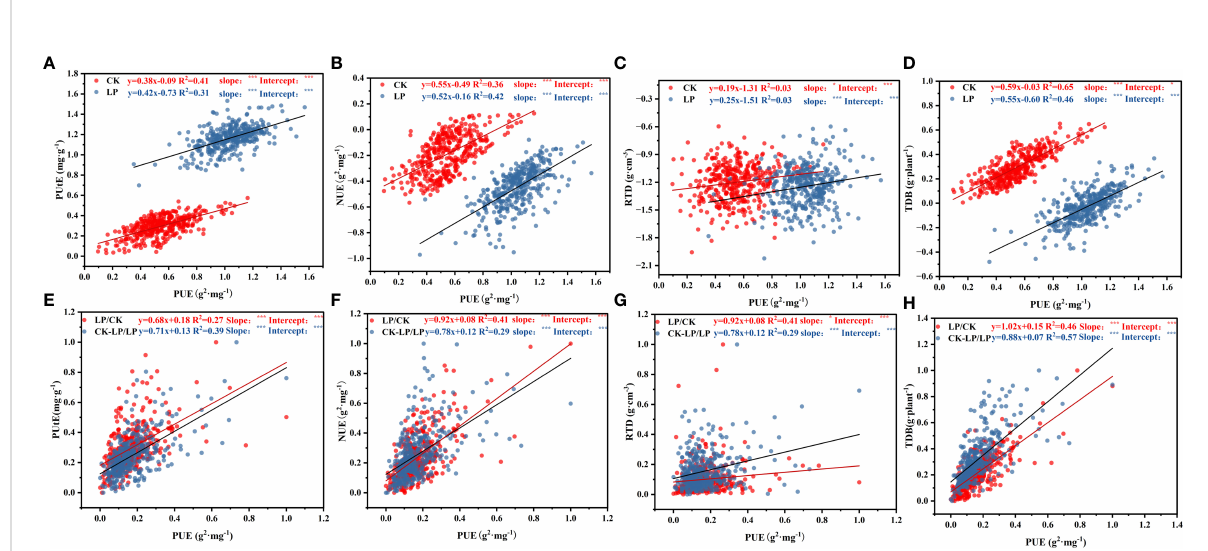
FIGURE 8 Standardized central axis linear relationships in morphological traits between PUE at both P supply and LP/CK, (CK-LP)/LP (Phosphorus stress index). Points are the mean values of four replicates per genotype. The data in fi gures (A – D) were log 10 transformed before analysis, and the data in fi gures (E – H) were normalized before analysis. ∗∗∗ P < 0.001. Trait notations: root tissue density (RTD), total dry biomass (TDB), nitrogen use ef fi ciency (NUE), phosphorus use ef fi ciency (PUE), phosphorus uptake ef fi ciency (PUtE). * Indicates that the signi fi cance of the slope and intercept of the fi tting curve of the two variables (p ≤